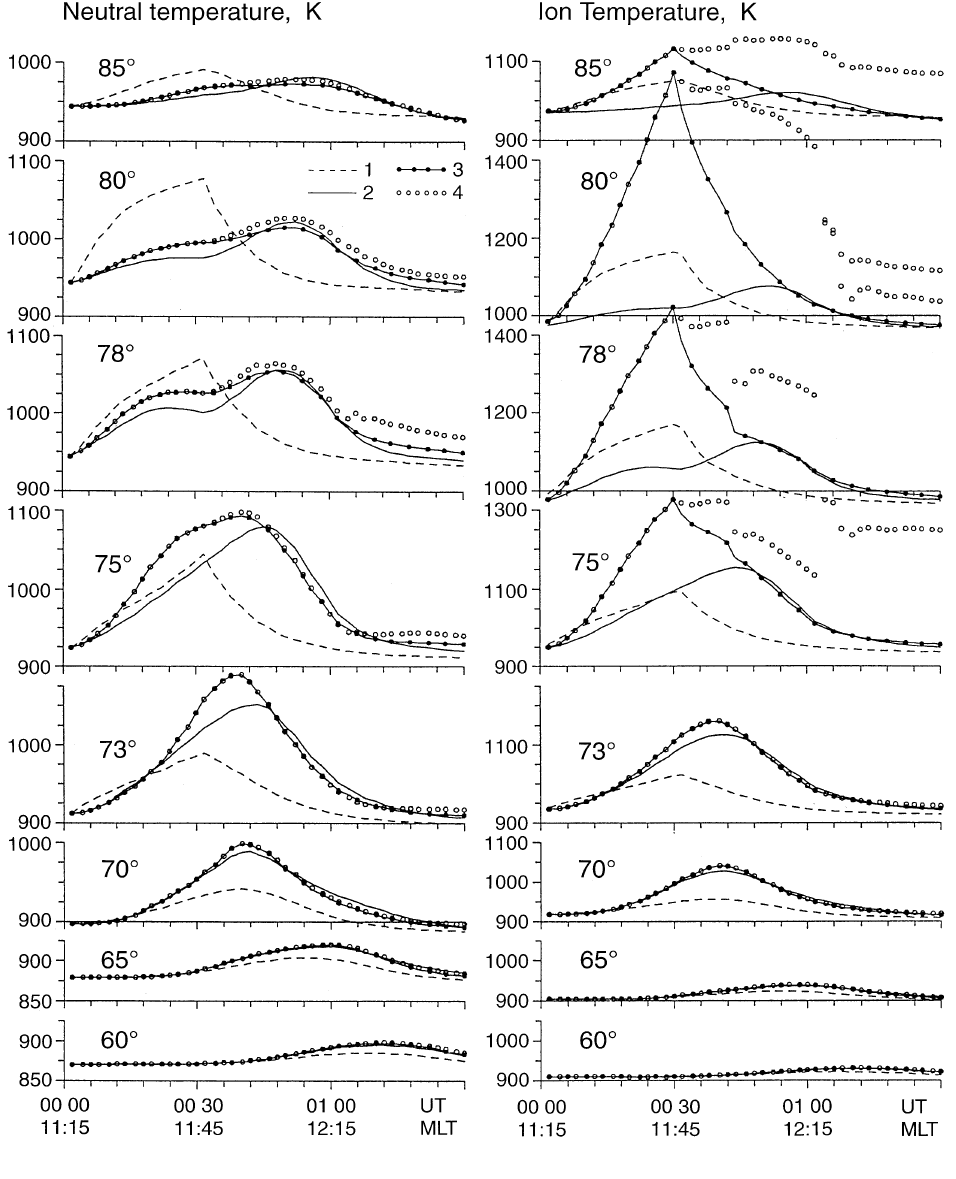
Fig. 6. The same as in Fig. 5 but for the neutral ( left - hand plots ) and ion ( right - hand plots )